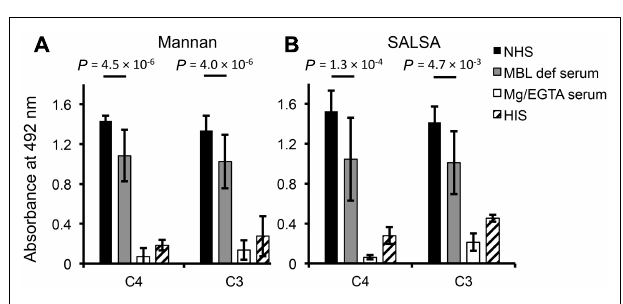
FIGURE 6 | Complement activation by surface-bound SALSA. In an ELISA assay mannan (A) or rSALSA (B) were coated in microtiter wells. NHS, MBL-deficient serum, MgEGTA-serum, or HIS (all 10%) was added and C4 and C3 deposition was measured using specific antibodies. Averages and SDs of three experiments performed in duplicate are